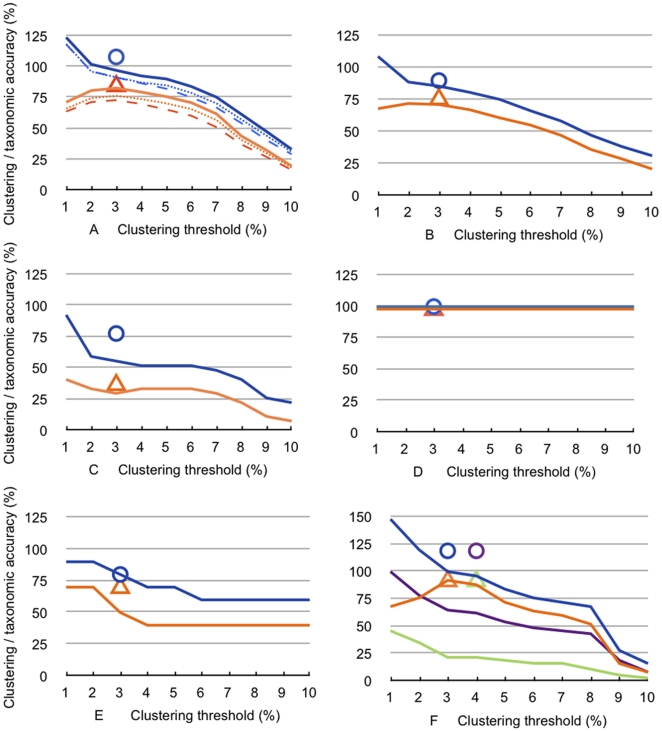

Agreement and taxonomic accuracy of molecular clusters estimated with different thresholds of DNA sequence divergence and the GMYC algorithm.Blue lines, agreement derived from clustering (percentage of clusters relative to number of morphological species used in the particular dataset), and orange lines, taxonomic accuracy of clusters (number of clusters containing all sequences of a named species and only those). (A) Full dataset and two modifications thereof (315 species: dashed lines; 260 species: dotted; 242 species: solid lines); (B) all Hydroporini; (C) Hydroporini: Sternopriscus; (D) Hydroporini: Tiporus; (E) Hydroporini: Megaporus; (F) Copelatinae: Exocelina, purple and green – agreement and taxonomic accuracy for the raw dataset, blue and orange – taxonomically revised dataset. Circles - agreement for GMYC entities, triangles – taxonomic accuracy of GMYC entities (in F, purple and green GMYC for taxonomically raw Exocelina dataset).